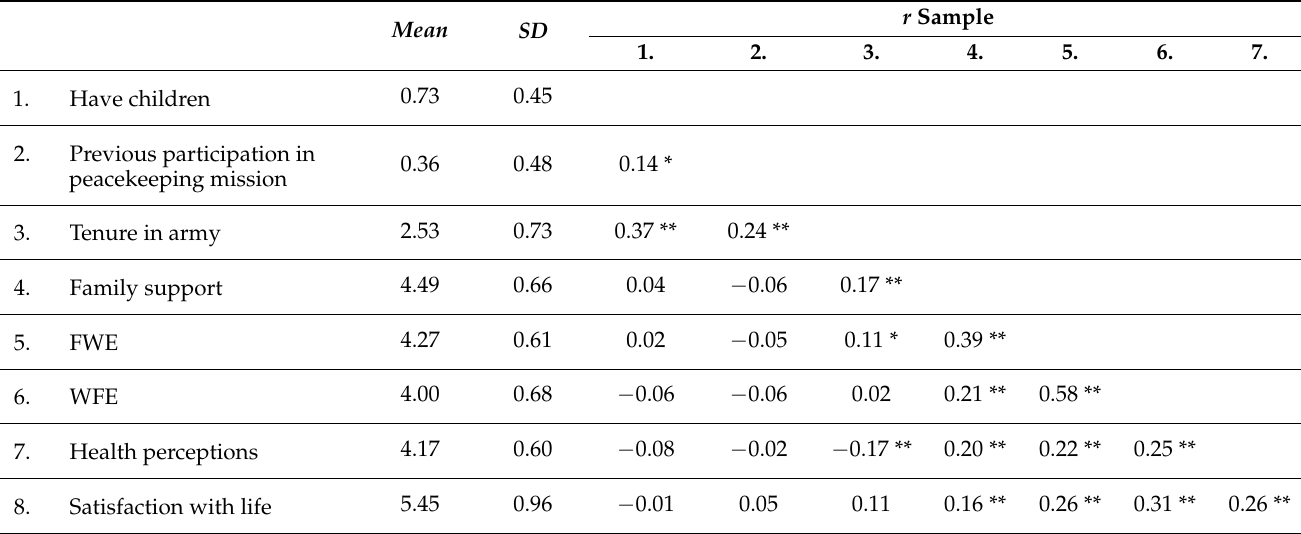
Table 1. Means, standard deviations, and correlations for the sample.